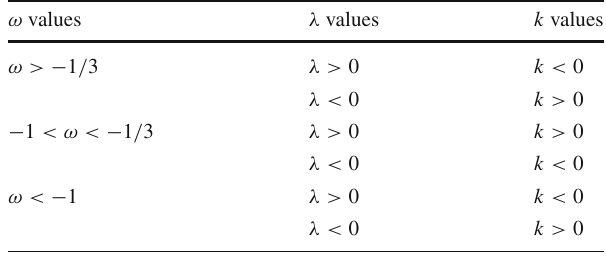
Table 1 The existence conditions for an ESU in the context of confor- mal Weyl